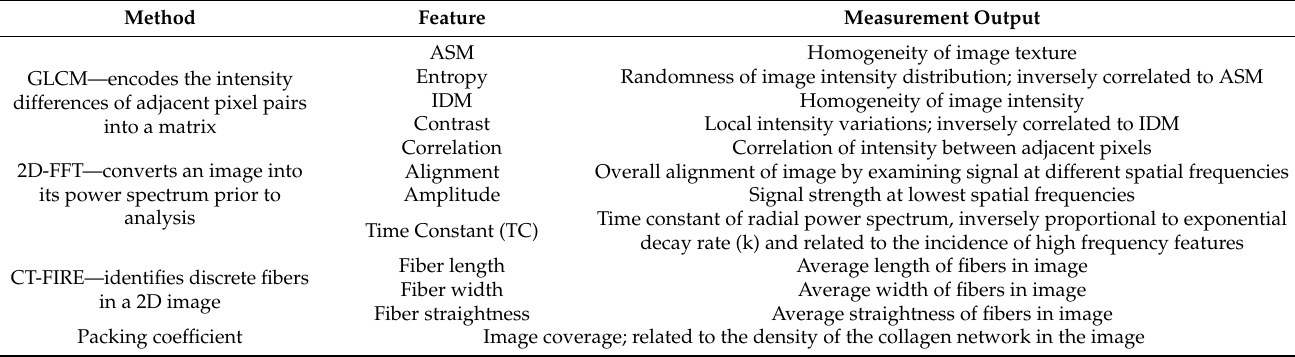
Table 1. Summary of different metrics used for Linear Discriminant Analysis